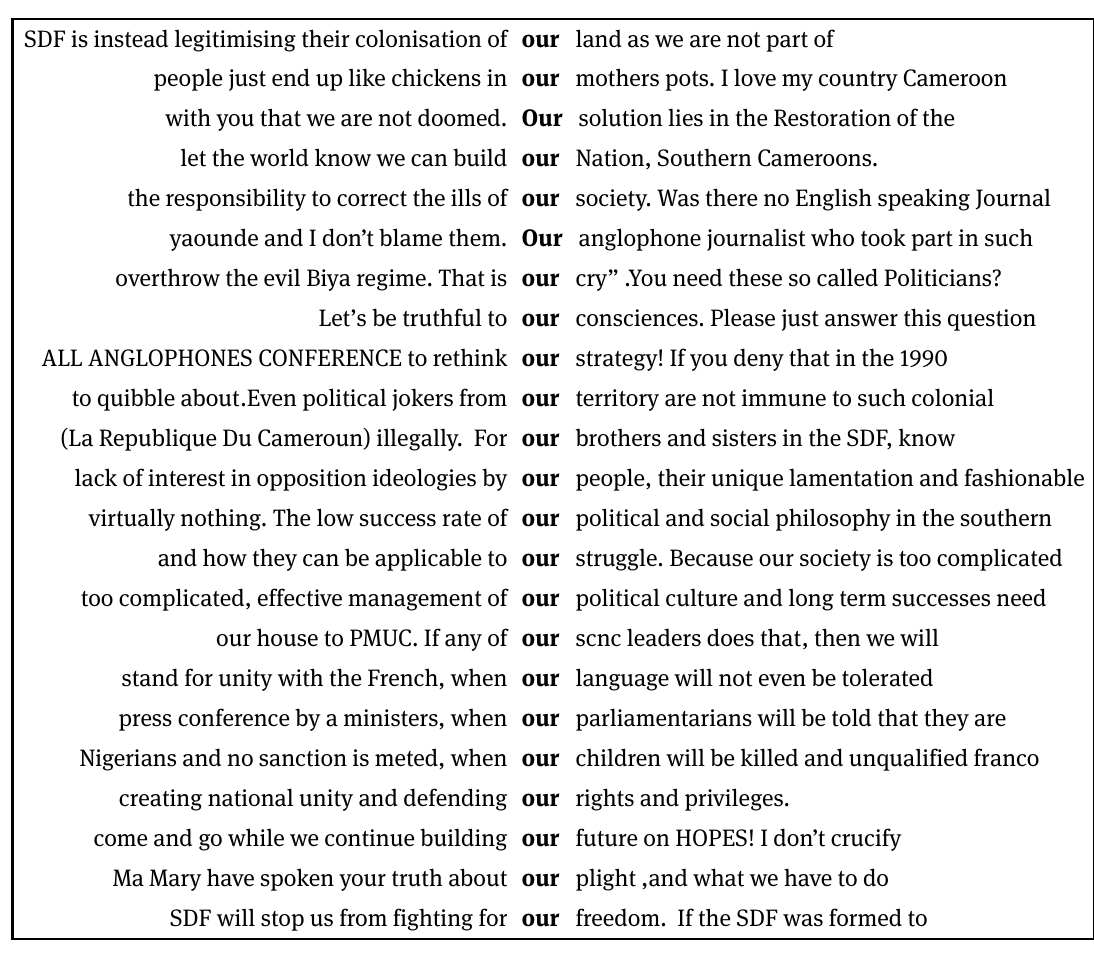
The forum member in (20) below uses the self-criticism topos as an in-group consolidation strategy. Here, indirect criticism or reproof for the group or some of its members is achieved through the use of the inclusive plural pronoun “us”. This works well because the out-group is presented as being actively involved in destroying the in-group, cf. “they